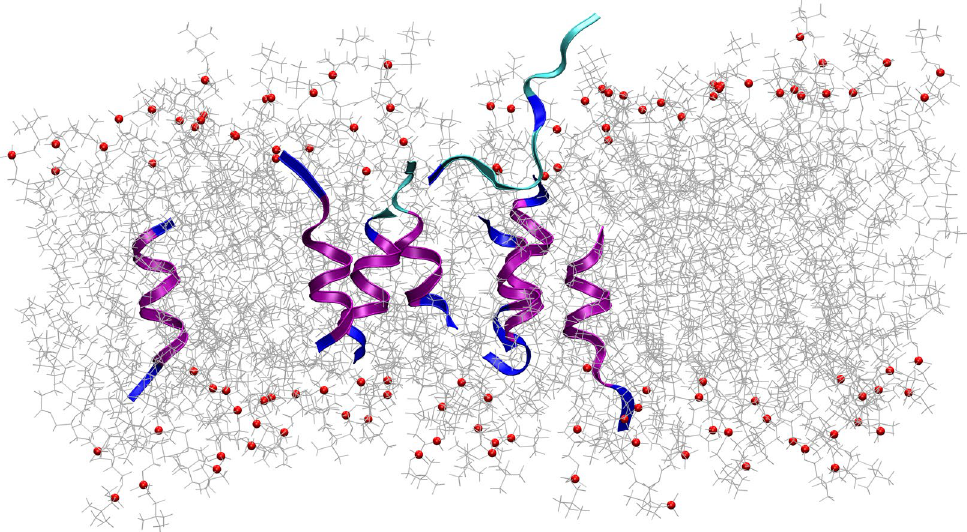
Figure 5. The MD simulations snapshot of the DPPC/Aβ 25–35 system after its equilibration. The peptides were initially distributed randomly within the membrane plane while oriented parallel to the lipid